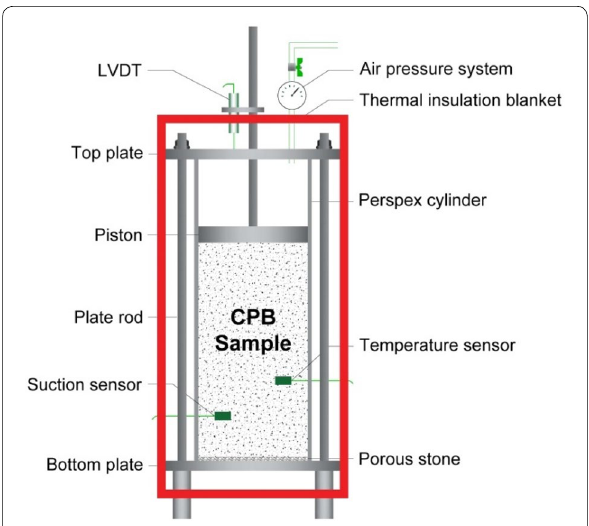
Fig. 1 Schematic diagram of THMC pressure cell